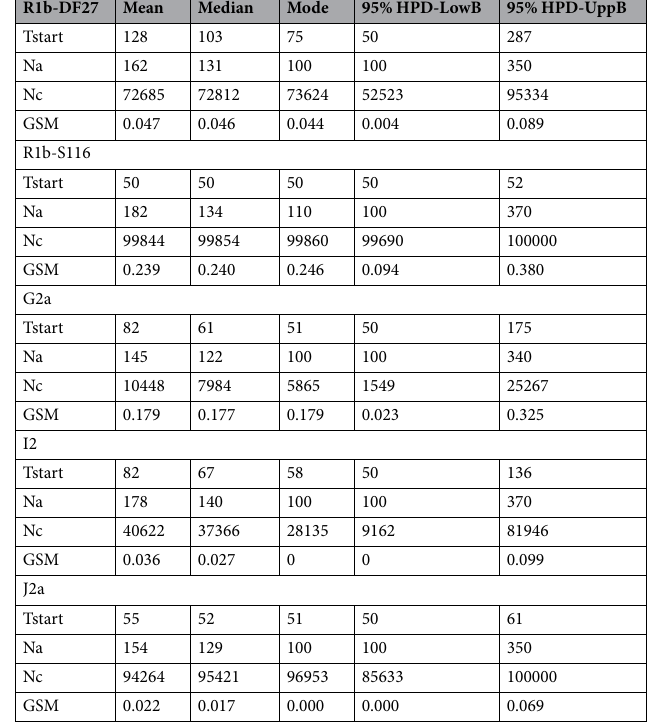
Table 4. ABC results for R1b-DF27 and reference haplogroups. GSM: Generalized Stepwise Mutation; HPD: Highest Probability